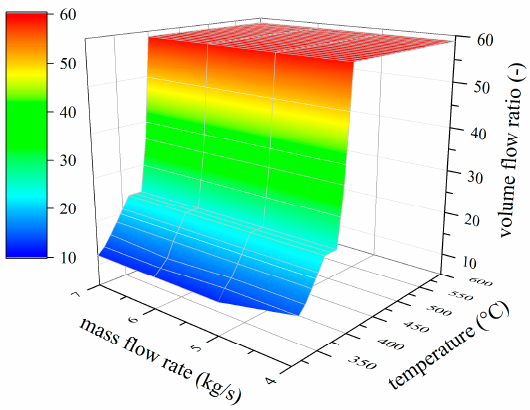
Figure 12. Size parameter of hexamethyldisiloxane depending on heat source temperature and mass flow rate.